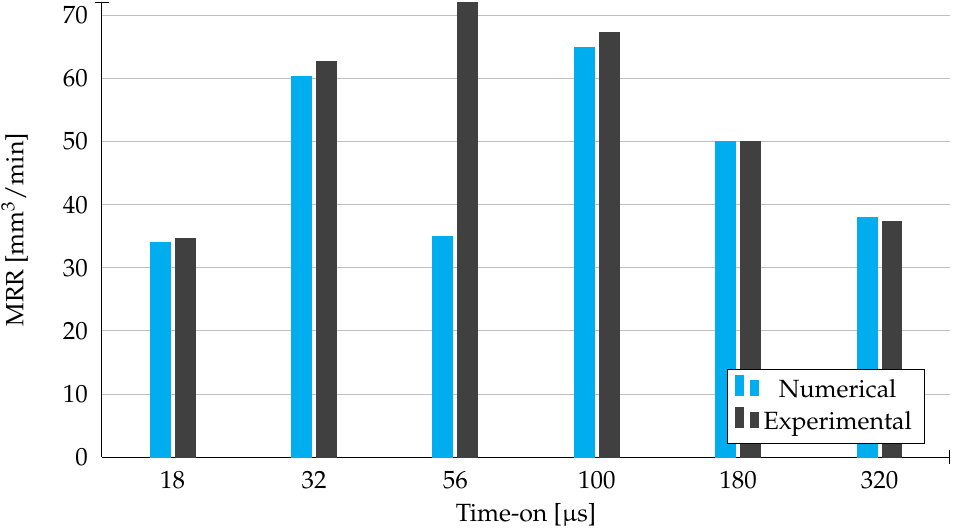
Figure 9. Material Removal Rate results obtained from experimental work and numerical simulation in